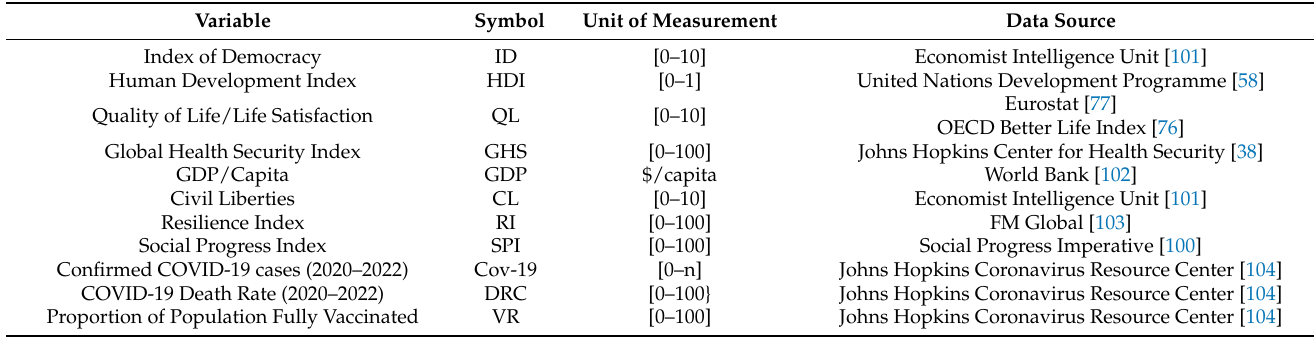
Table 1. Research variables.